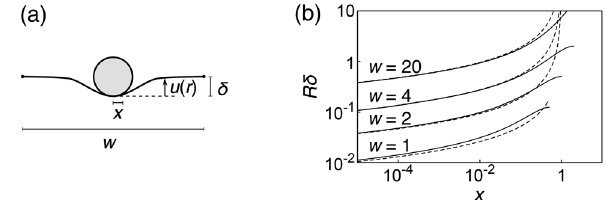
FIG. 13. Wide nanotube deformation. (a) Parametrization of the membrane deformation induced by the (gray) indenter. (b) Nonlinear relation between the indentation depth δ and the contact radius x depending on the dimensionless membrane width w . Solid lines represent the full relation of Eq. (A14), and dashed lines picture the δ → 0 asymptotic relation of Eq.